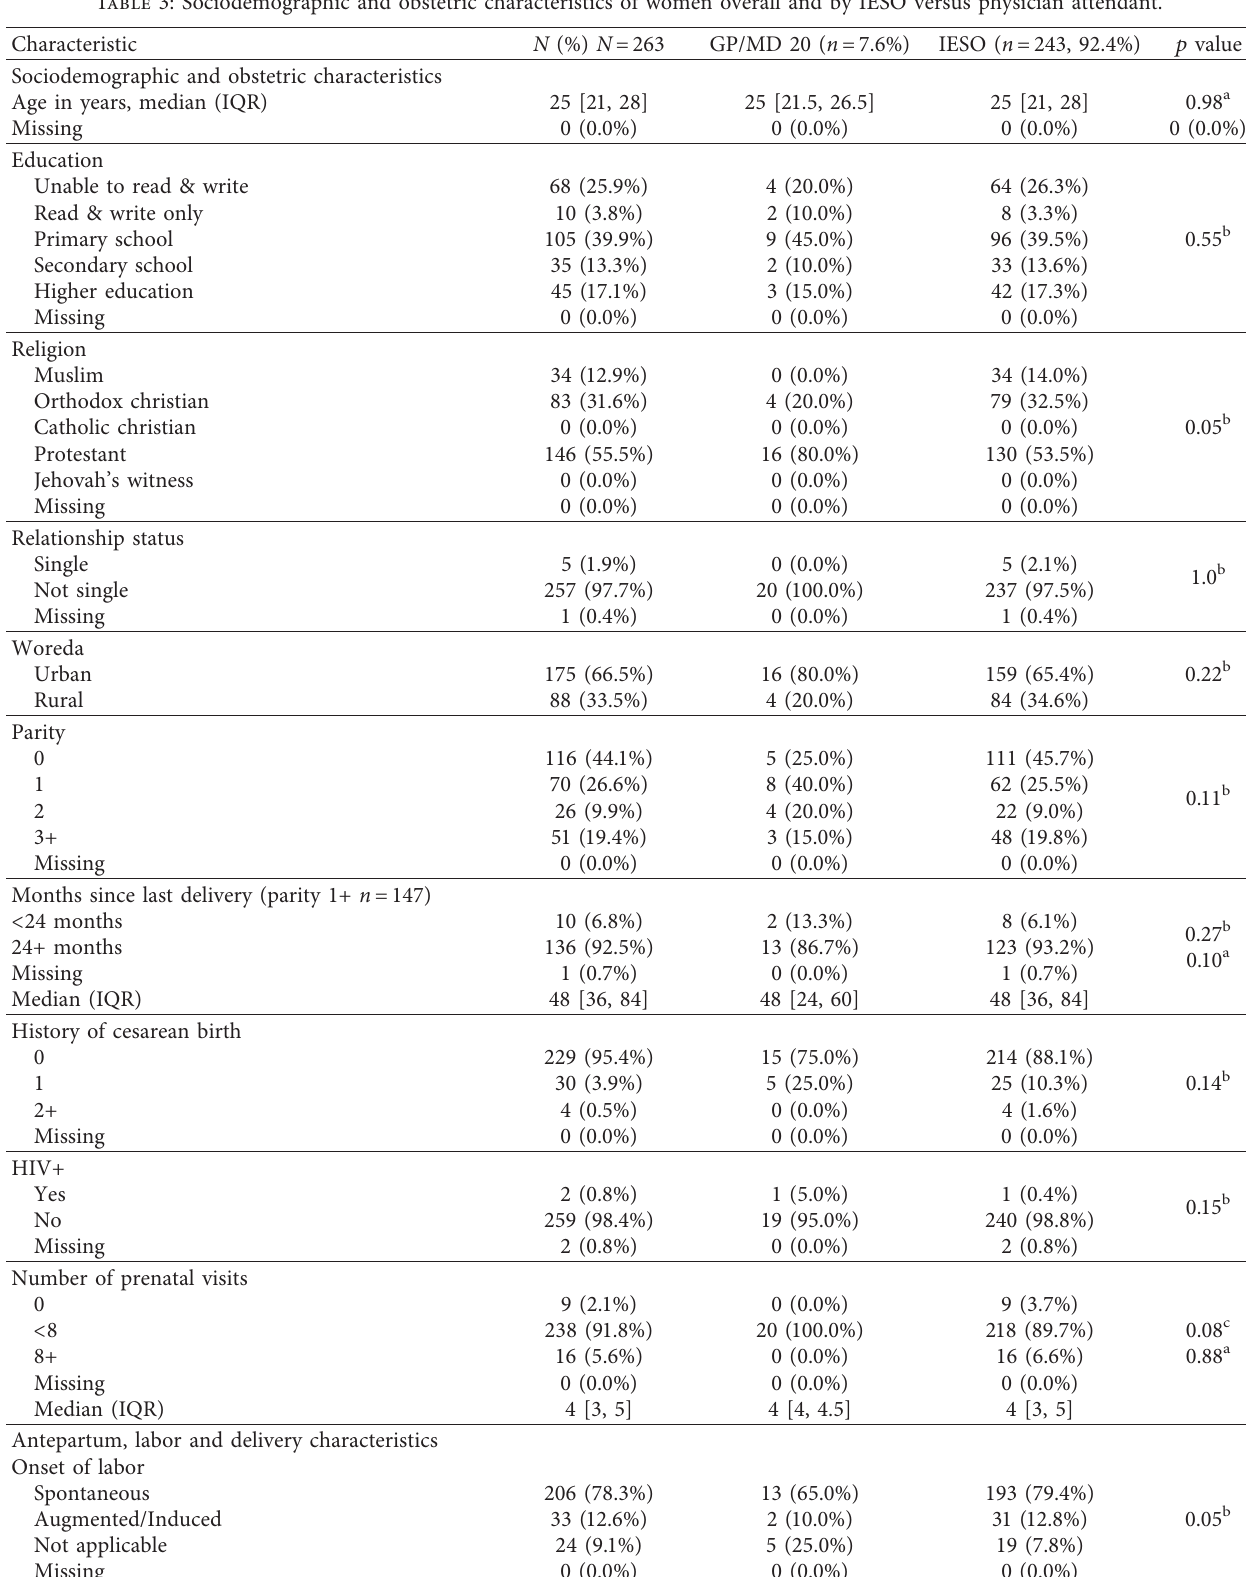
Table 3: Sociodemographic and obstetric characteristics of women overall and by IESO versus physician attendant.